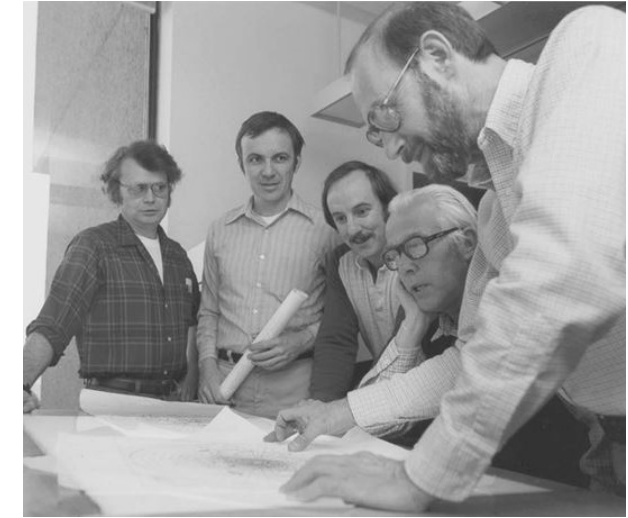
Figure 2. Members of the Empirical Studies Group, with (left to right) Paul Julian, Roland Madden, Dennis Shea, Chester Newton (group head), and Harry van Loon, in about 1980